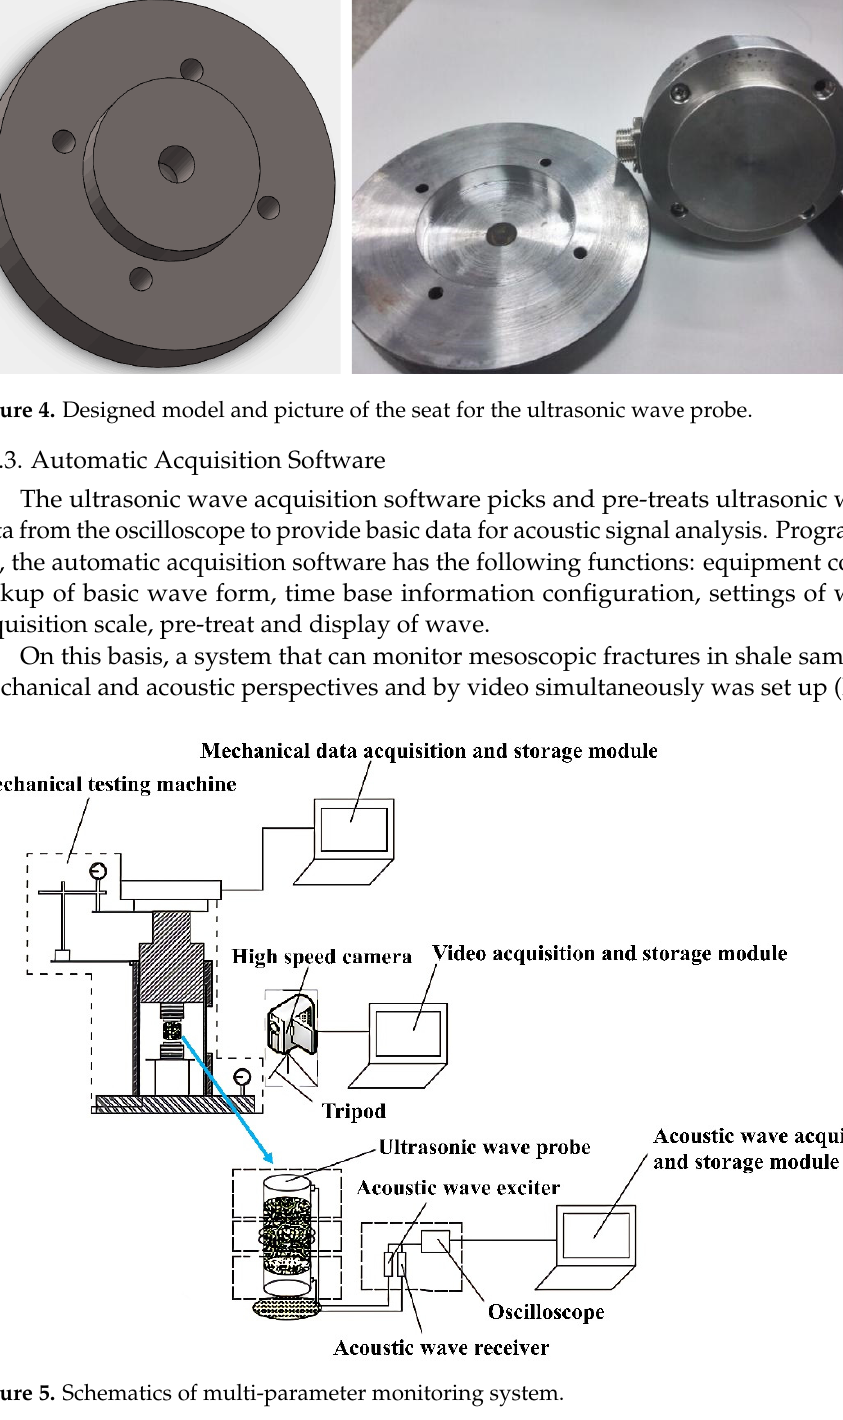
Figure 3. Structure of the ultrasonic wave probe.